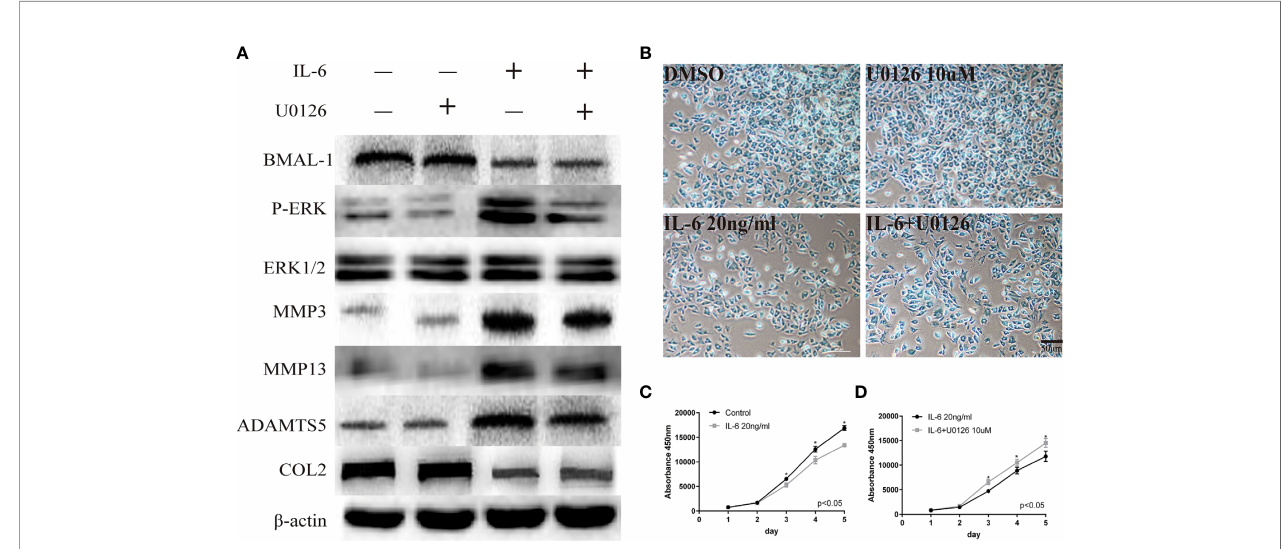
FIGURE 4 | Regulatory relationship between BMAL-1/P-ERK and IL-6. (A) Western blot assays demonstrate the relationship between BMAL-1, P-ERK, MMP3, MMP9, MMP13, and COL2, while the expression levels of ERK1/2 and b -actin were the same in the cartilage tissues of the control group, CRD group and REC group. (B) Alcian blue staining results for MCCs stimulated with 20 nM or 10 µM U0126 and 20 ng/ml IL-6 for 12 h. (C , D) A CCK-8 assay was used to examine the cell proliferation of each group and the effects of u0126; the absorbance was measured at 450 nm. All experiments were performed in triplicate, and the results are expressed as the mean ±SD. The P value is written in the fi gure corner. Scale bar: 50 mm. *P <